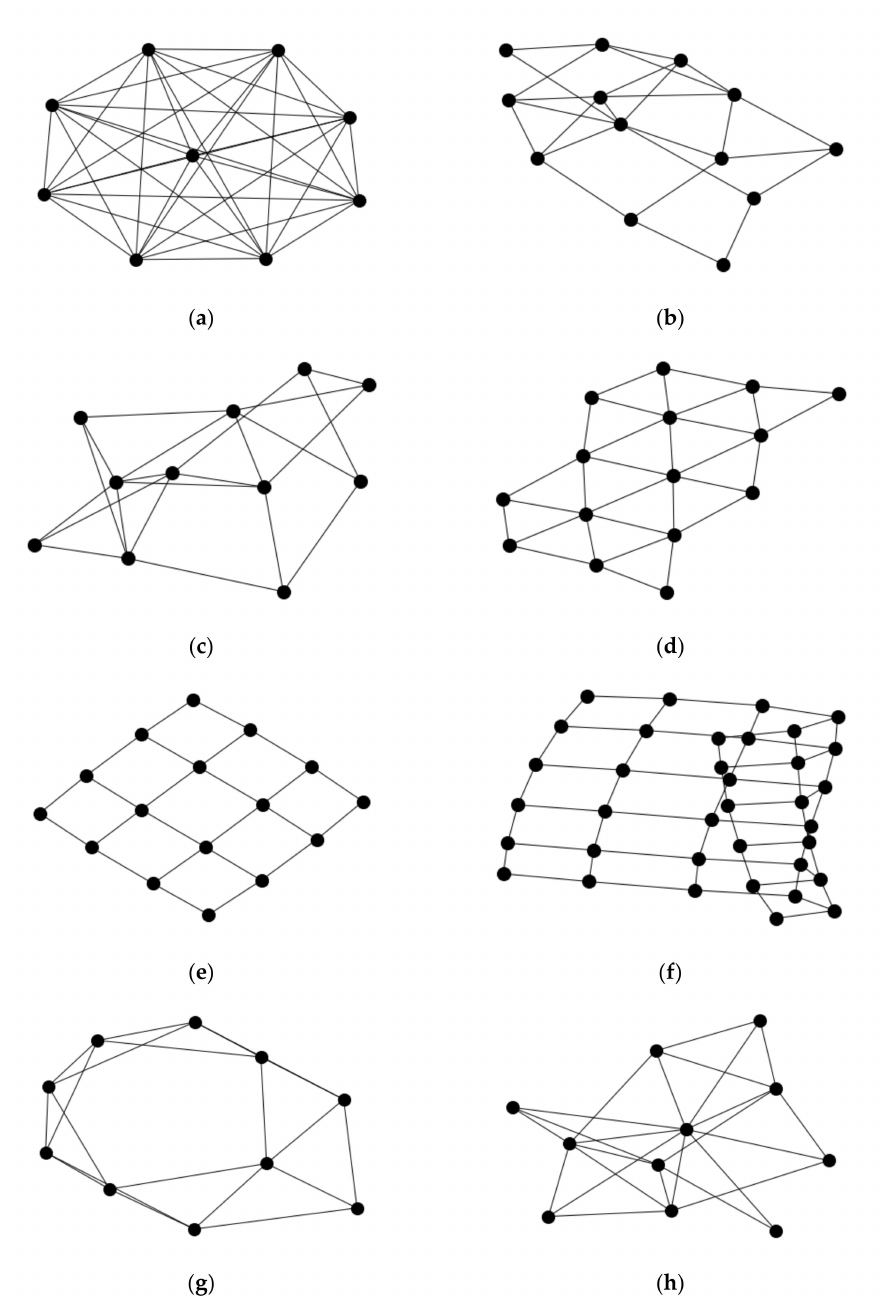
Figure 2. Images of simulated networks by the model of generation and drawing orientation.